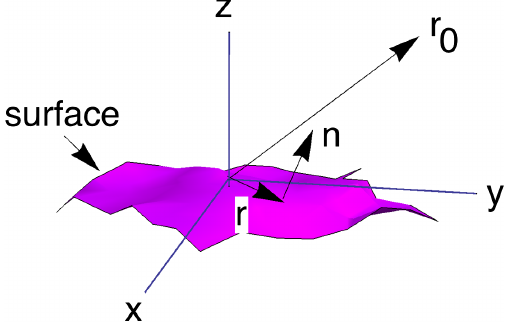
FIG. 19. Coordinate system illustrating the vectors r , r 0 , and n